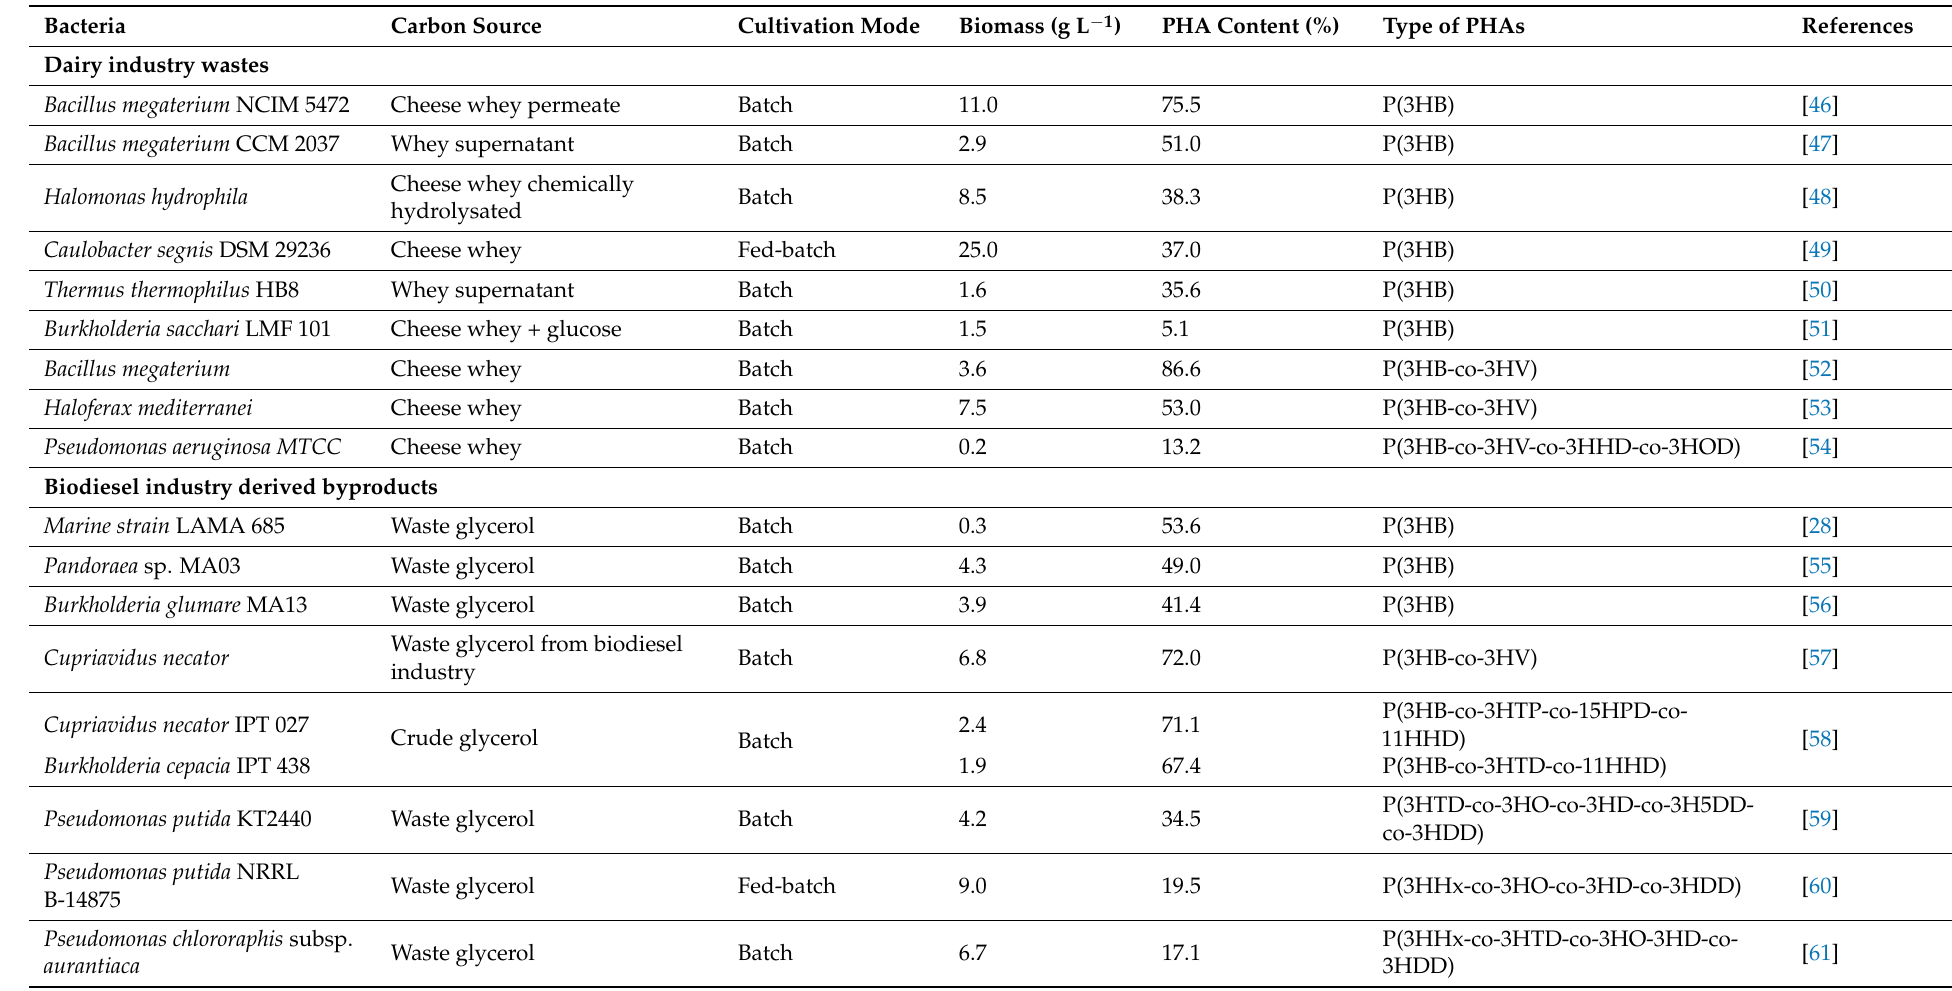
Table 3. Comparison of PHAs production processes by pure bacteria cultures from waste